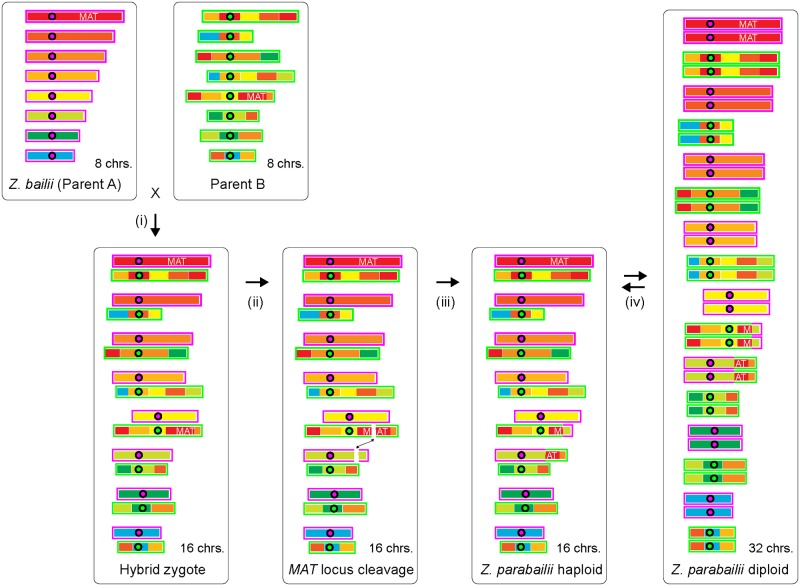
Cartoon of key steps in the origin of the Z. parabailii genome.Chromosome regions (thick bars) are colored according to their location in Z. bailii (magenta outlines). The corresponding homeologous regions are scrambled in Parent B (green outlines). Circles represent centromeres. (i) Interspecies mating occurred between Parent A (Z. bailii) and Parent B. The genomes differed by about 34 rearrangement breakpoints and 7% nucleotide sequence divergence. The resulting zygote was unable to form viable spores because of the noncollinearity of its chromosomes. (ii) Expression of HO endonuclease in the zygote, due to the absence of a1-α2, resulted in cleavage of the B-copy of the MAT locus and ectopic recombination with the GDA1-YEF1 region of the A-subgenome, causing a reciprocal translocation. (iii) The resulting genome has only 1 functional MAT locus and behaves as a haploid. Recombinations and other exchanges between homeologous regions of the 2 subgenomes, such as those that exchanged the HML/HMR regions, occurred but are not shown here for simplicity. (iv) The current life cycle of Z. parabailii involves mating between 16-chromosome haploids to form 32-chromosome diploids, which immediately sporulate to regenerate 16-chromosome haploids. Z. parabailii is homothallic because it contains an intact HO gene, which allows interconversion between MATa and MATα haploids and hence autodiploidization. chrs., chromosomes.